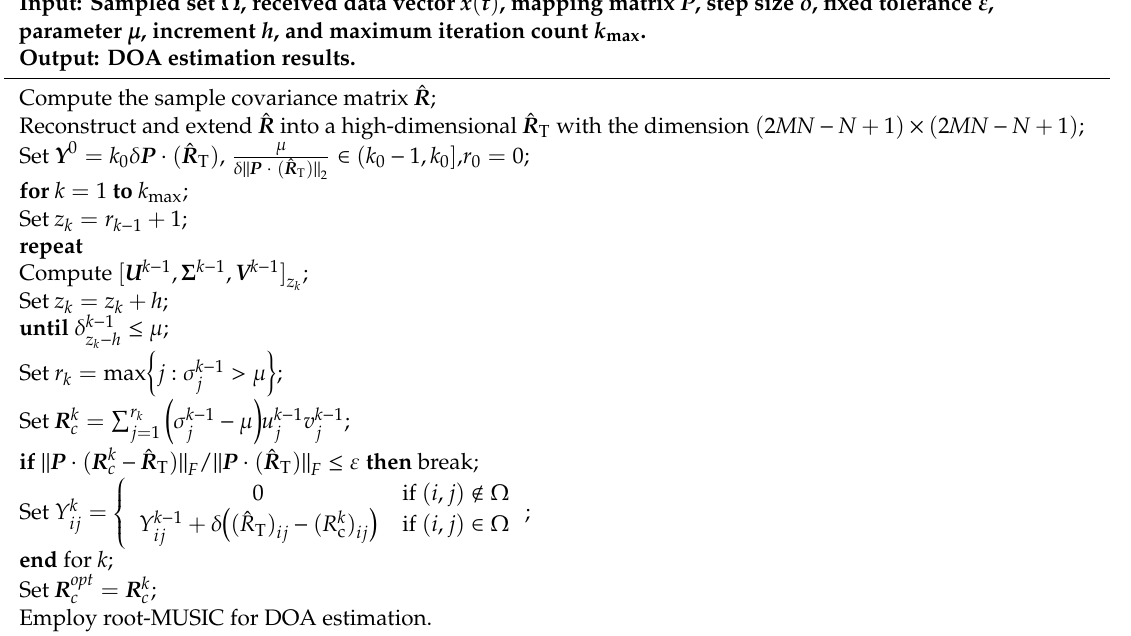
Table 1. The proposed singular value thresholding- (SVT) based direction of arrival (DOA) estimation